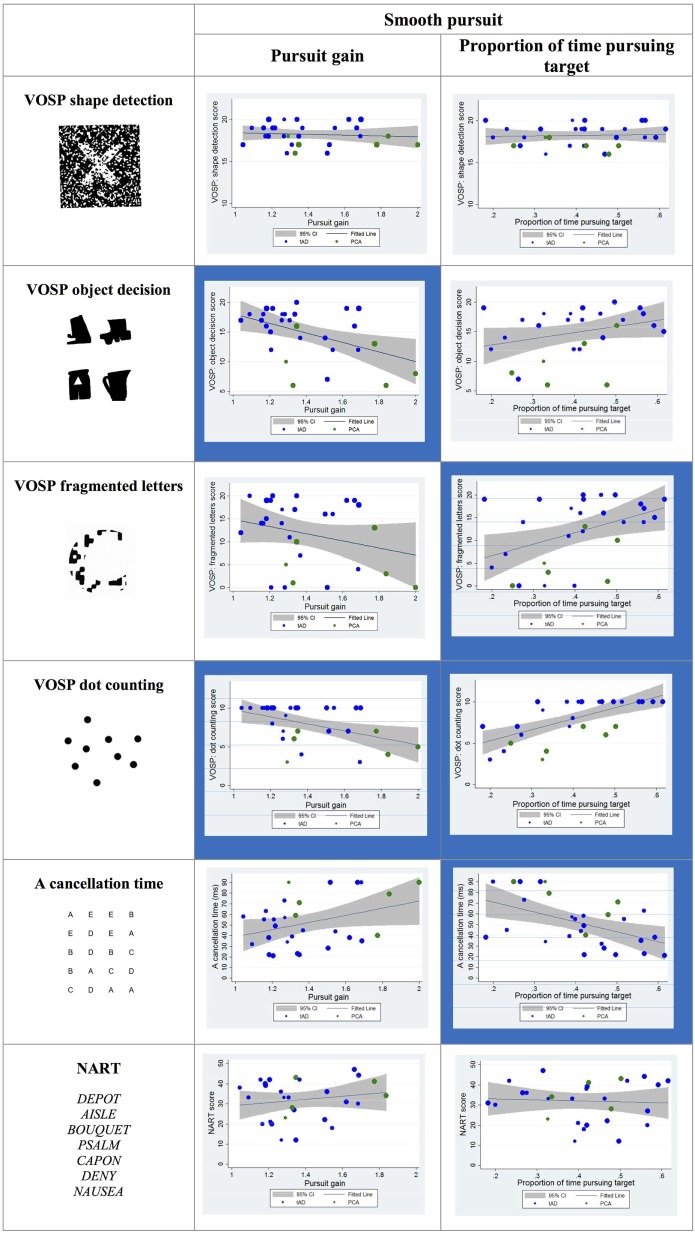
Scatter plots showing correlations between smooth pursuit metrics and visual cognitive scores for young onset Alzheimer’s disease patients. Statistically significant correlations are marked with a blue background and statistical trends (p > 0.05 and p < 0.10) in a lighter blue. Best fit line and 95% CI are shown. Each data point corresponds to a participant and its size is proportionate to the Mini-Mental State Examination score (disease severity). typical AD (tAD) individuals are shown in blue and posterior cortical atrophy (PCA) in green.